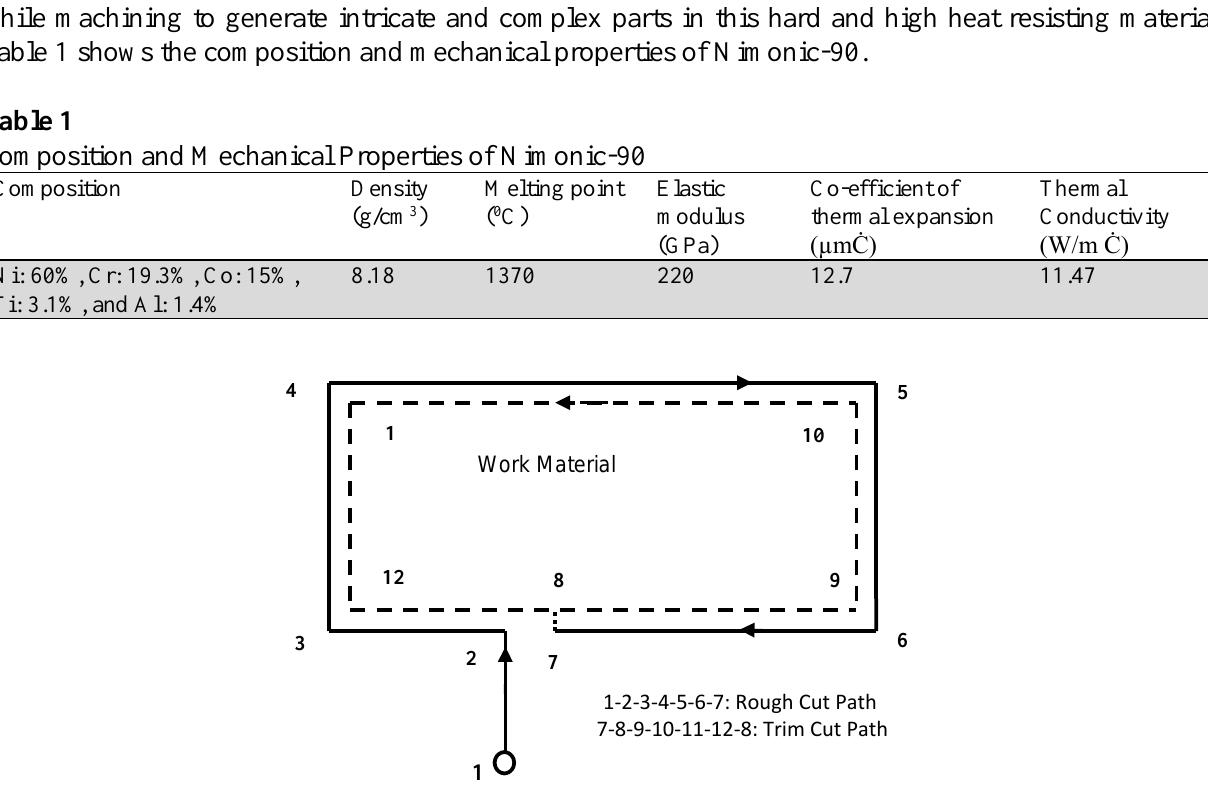
Fig. 3. Geometry of wire path for rough and trim cut